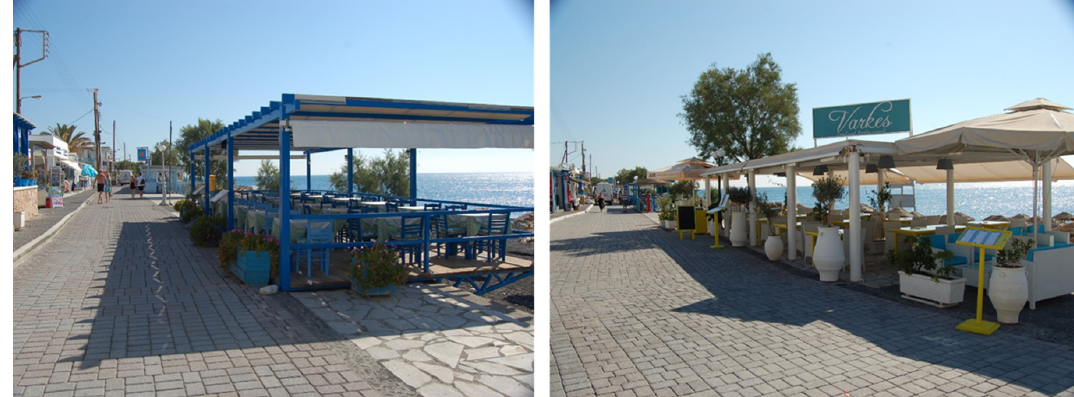
Figure 7. Characteristic structures in the coastal front of the settlement with high risk of drifting due to a tsunami wave, increasing the possibility of damage in the surrounding buildings.